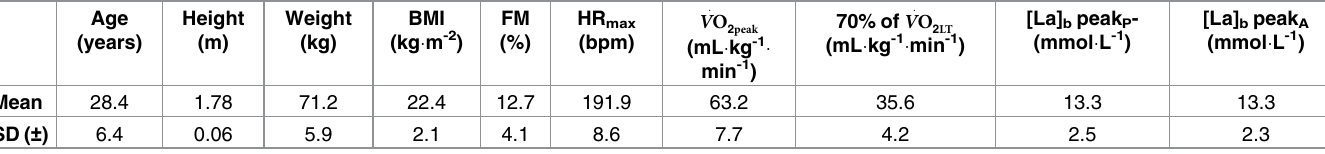
Average data calculated for seventeen subjects. Abbreviations: BMI, body mass index; FM, fat-mass; HR max , maximal heart rate; _ V O consumption; 70% of _ V O , 70% of the oxygen consumption corresponding to the lactate threshold; [La] b peak, average peak blood lactate concentration 2 LT achieved before the passive ( P ) and the active ( A ) recovery conditions (average value was computed for twelve subjects for passive recoveries); SD, standard